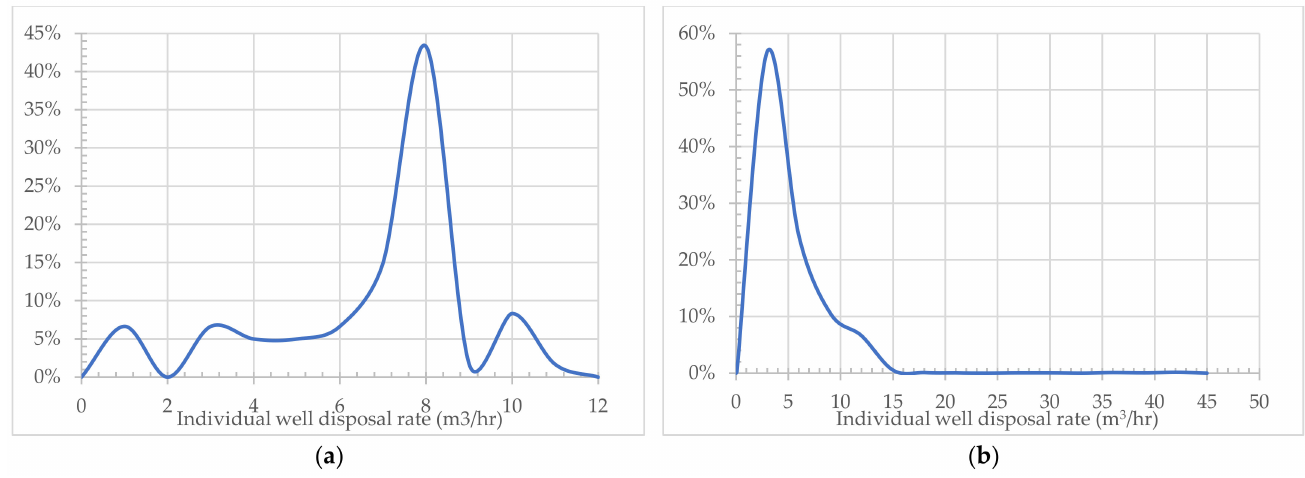
Figure A27. Historical per-well water injection rate ( X -axis) frequency ( Y -axis) distributions (January 1962–December 2022) in ( a ) the Peechee Formation; ( b ) the Camrose